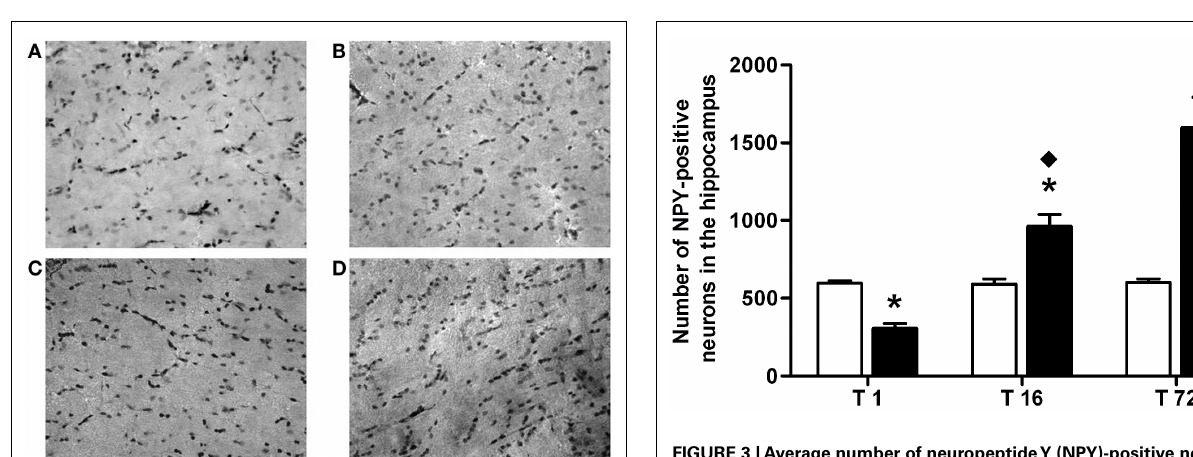
FIGURE 3 |Average number of neuropeptideY (NPY)-positive neurons in the hippocampus ofACD and control rats at different times following the last intragastric infusion . Each value represents the mean ± S.D. of 12 sections for each experimental condition. ( (cid:3) )